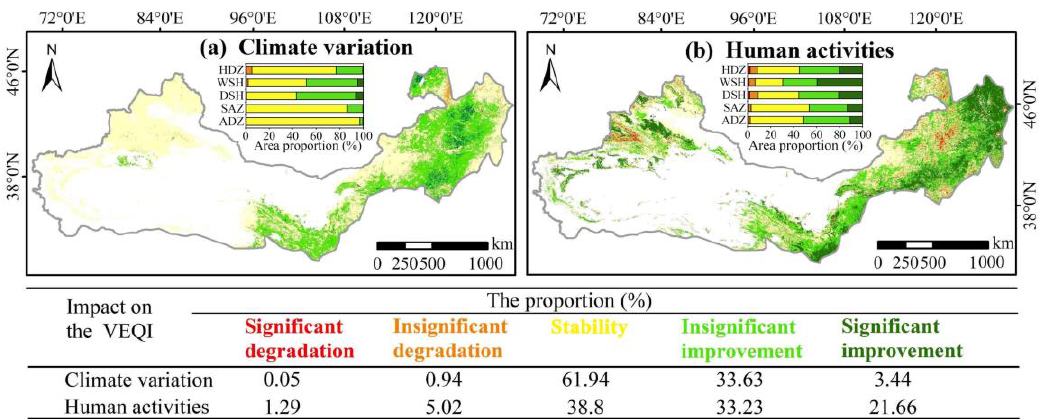
Figure 11. Impacts of climate variation and human activities on VEQI: ( a ) impact of climate variation on VEQI; ( b ) impact of human activities on VEQI.